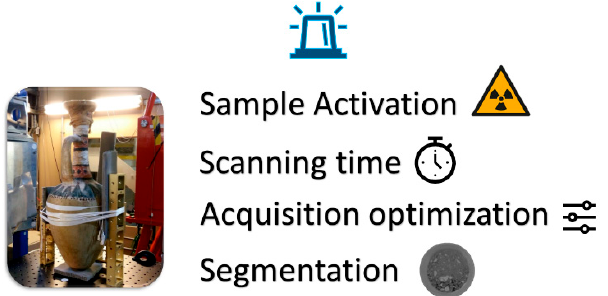
Figure 1. Overview of the main in Neutron Imaging applied to cultural heritage.